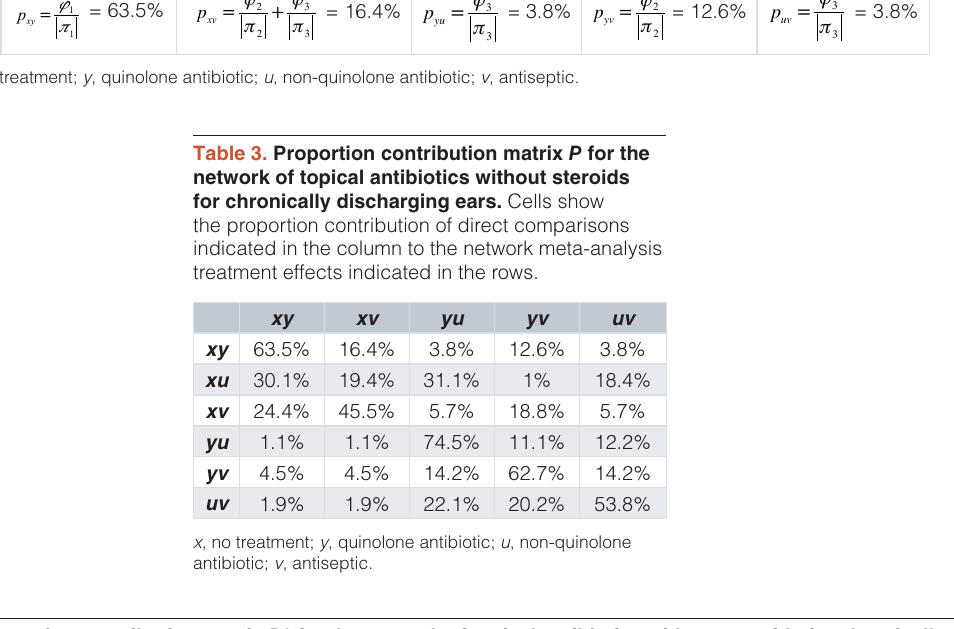
Table 4. Study proportion contribution matrix P* for the network of topical antibiotics without steroids for chronically discharging ears. Cells show the proportion contribution of individual studies indicated in the column to the network meta-analysis treatment effects indicated in the